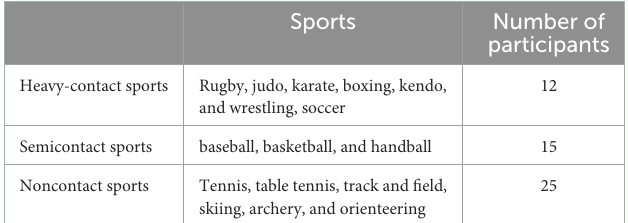
Tennis, table tennis, track and field, skiing, archery, and orienteering